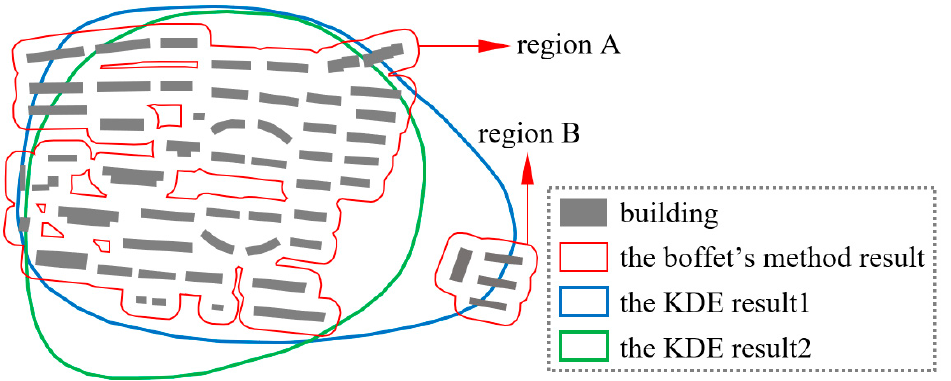
Figure 4. Relationship between buildings, Boffet’s method result, different KDE results, and ob- tained urban areas. urban